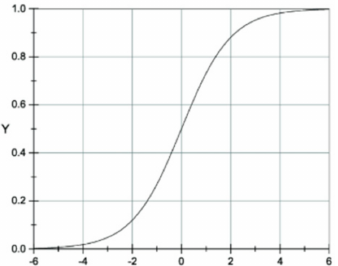
Figure 3. Logistical function with a border value between 0 and